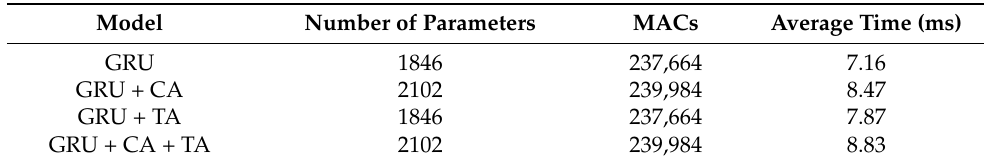
Table 6. Consumption of Resources of the four